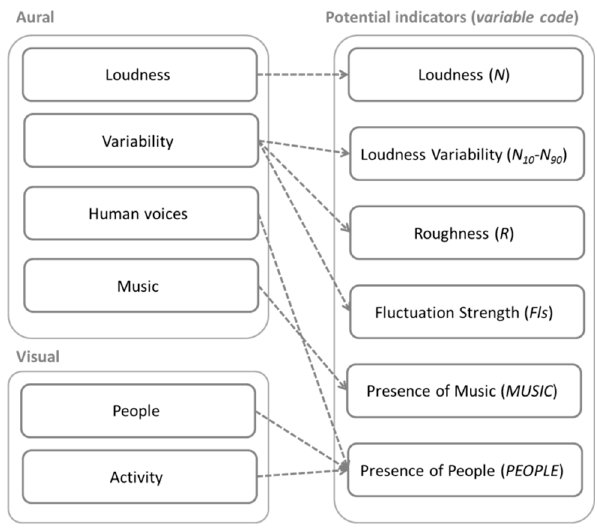
Figure 3. Schematisation of variables hypothesised for the elements of the group interview.